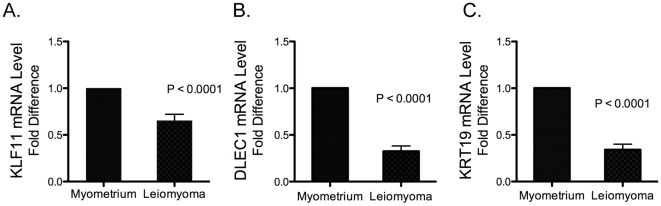
mRNA levels of KLF11, DLEC1 and KRT19 in uterine leiomyoma and matched adjacent myometrial tissues.mRNA levels of (A) KLF11, (B) DLEC1, and (C) KRT19 were quantified using all 18 samples used in microarrays plus the addition of 7–10 new Caucasian samples. mRNA levels in leiomyoma and matched myometrium were quantified by real-time PCR, they were first normalized to GAPDH. Then, to allow comparisons of data obtained from samples from different subjects, mRNA levels in the myometrial tissues were normalized to 1. KLF11 (n = 25; P<0.0001), DLEC1 (n = 28; P<0.0001) and KRT19 (n = 25; P<0.0001). The data are shown as the mean +/− SEM. P<0.05 versus myometrium tissues.